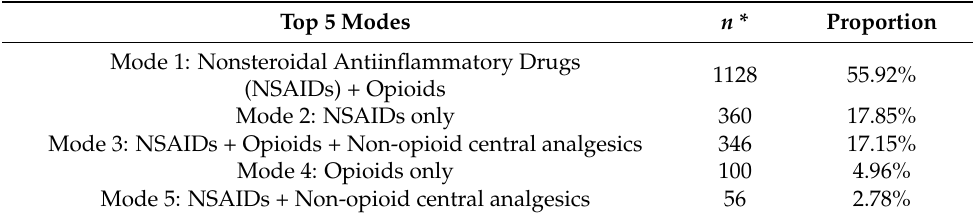
Table 4. Top 5 modes of analgesics utilization based on drug